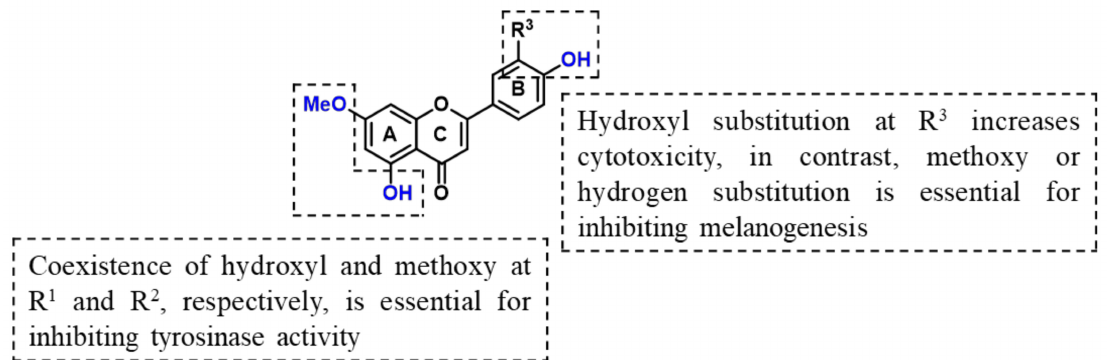
Figure 5. Velutin derivatives along with their structure–activity relationship for the inhibition of